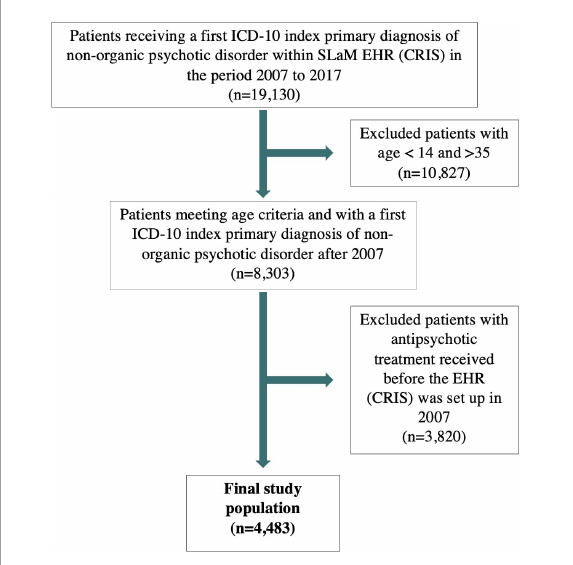
FIGURE1 Flow-chart of study population. ICD, internal classification of diseases; SLaM, South London and